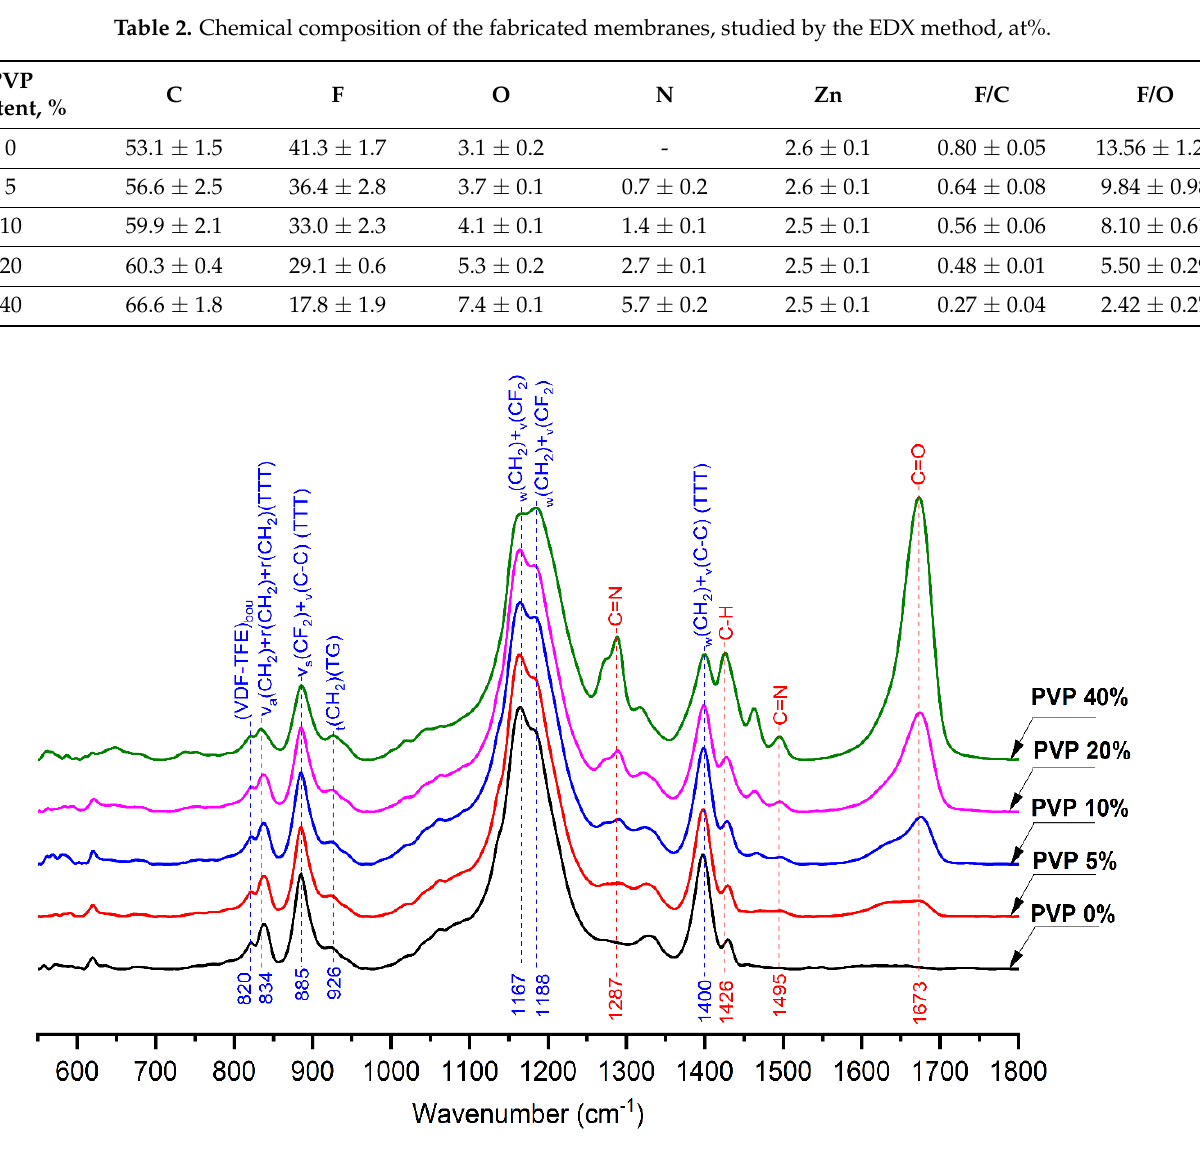
Figure 2. IR spectra of VDF-TeFE/PVP/ZnO membranes with various PVP content. With the increase of PVP content, the bands corresponding to PVP occur: 1650 cm − 1 stretching vibration of the C=O in the pyrrolidone group, 1421 cm − 1 and 1372 cm − 1 correspond to the CH deformation modes from the CH 2 group in PVP, 1287 cm − 1 which is related to the C–N bending vibration from the pyrrolidone structure, the band at about 1495 cm − 1 refers to the characteristic vibration of C=N (pyridine ring) [30,31]. The pres- ence of bands at 840, 884, and 1398 cm − 1 and the absence of shifts regardless of PVP content is evidence for the preservation of the trans- conformation of VDF-TeFE molecules with high dipole moment. The presence of the bands corresponding both to PVP and VDF- TeFE confirms the fabrication of composite membranes as well as the results of EDX stud- ies. It should be noted that the addition of hydrophilic PVP in the range of 0 to 40 wt% had no effect on the surface properties of the fabricated membranes, which is demon- strated by the insignificant changes in water contact angles (122° for the control membrane and 110° for the membranes containing 40 wt% of PVP) (Figure 1). The XRD patterns of the fabricated membranes are presented in Figure 3.